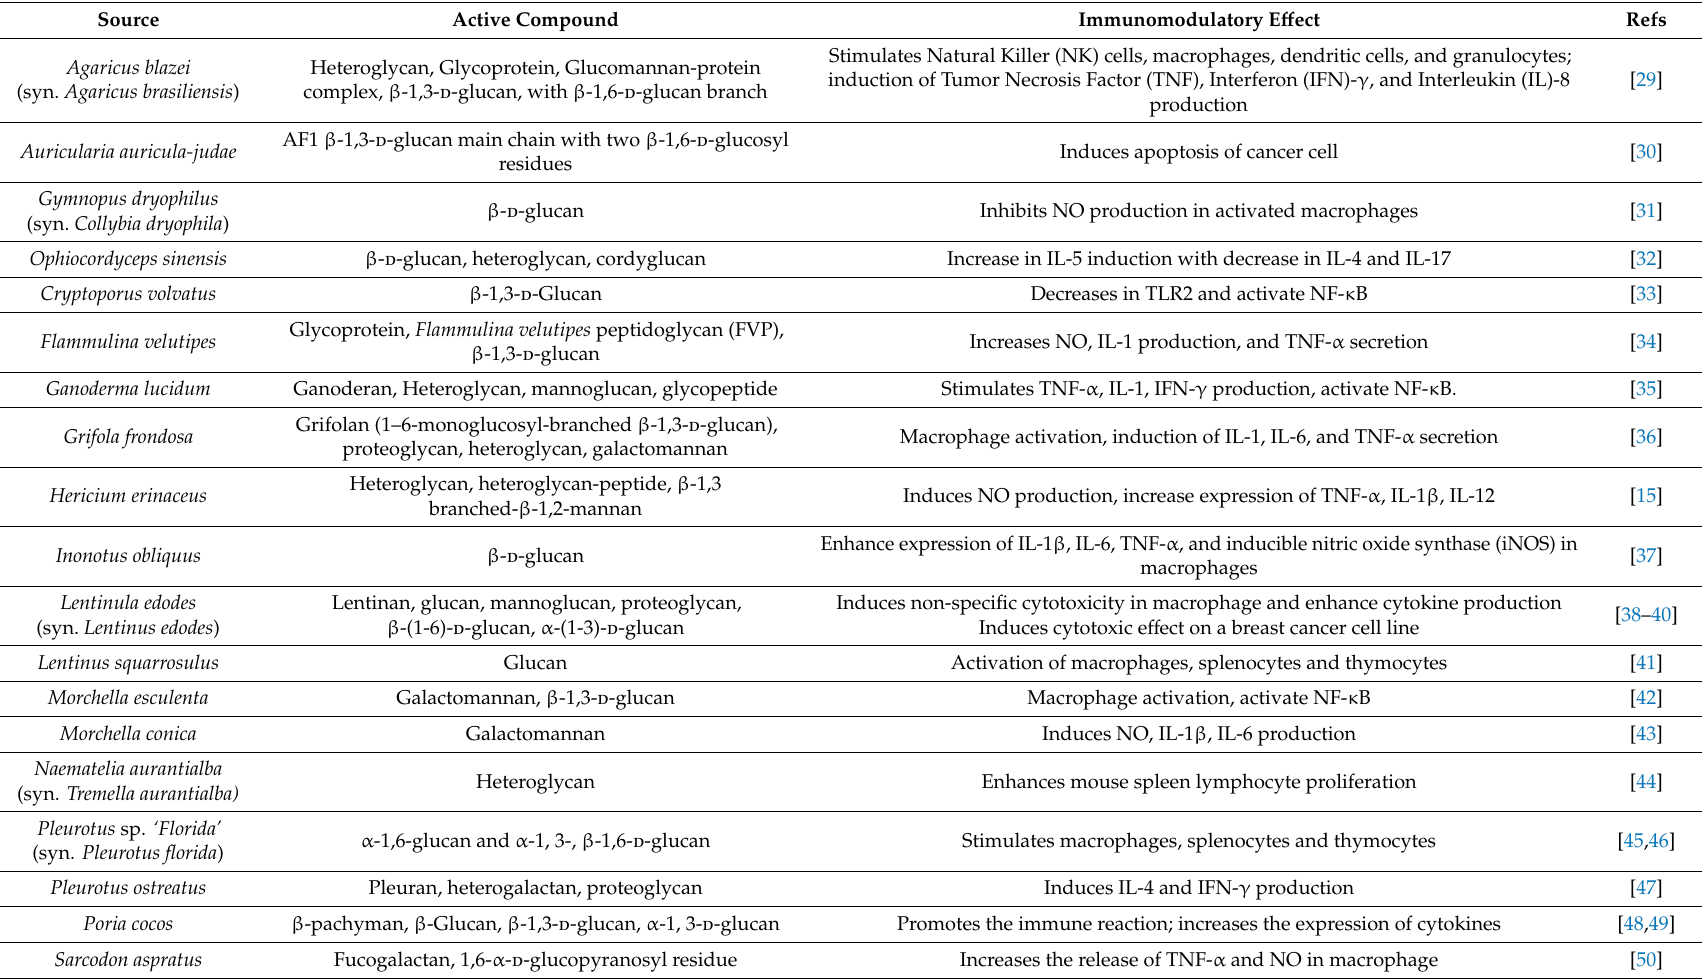
Table 2. Major immunomodulatory polysaccharides from medicinal mushrooms and their immunomodulatory e ff